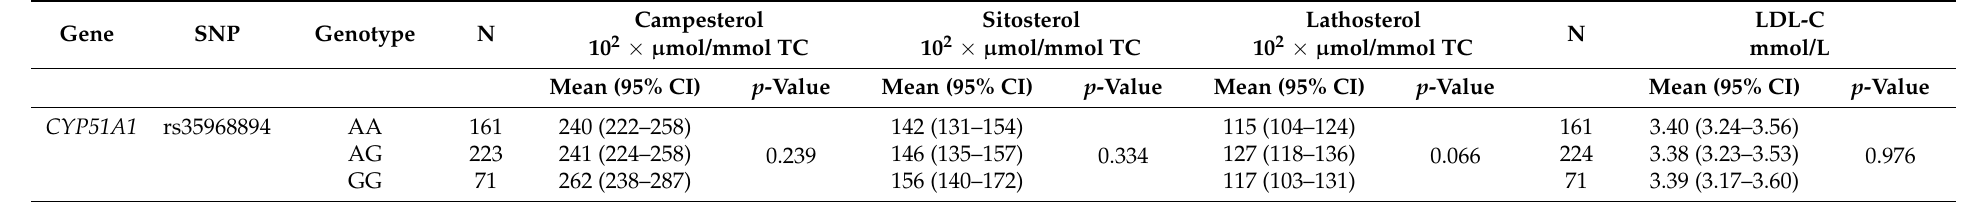
Table 3. Associations between various SNPs in endogenous cholesterol synthesis genes with serum TC-standardized campesterol, sitosterol and lathosterol levels (N = 455), and serum LDL-C concentrations (N =